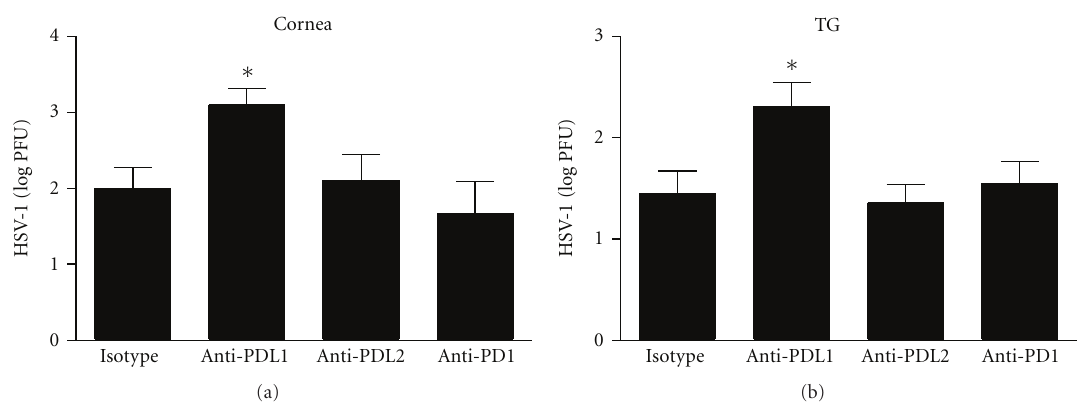
Figure 1: HSV-1 viral load following anti-PD-L1, anti-PD-L2, or anti-PD-1 antibody treatment. C57BL/6 mice were infected with 1,000 PFU HSV-1/cornea. At days 2, 4, and 6 p.i. mice were administered neutralizing antibody to PD-L1, PD-L2, PD-1, or control IgG. The corneas (a) and TG (b) were harvested at 7 days p.i. and HSV-1 viral titers were assessed by plaque assay. This figure summarizes three experiments ( n = 9). Each bar represents the mean ± SEM. ∗ P < 0 . 05 comparing the indicated group to the isotypic control antibody-treated group.